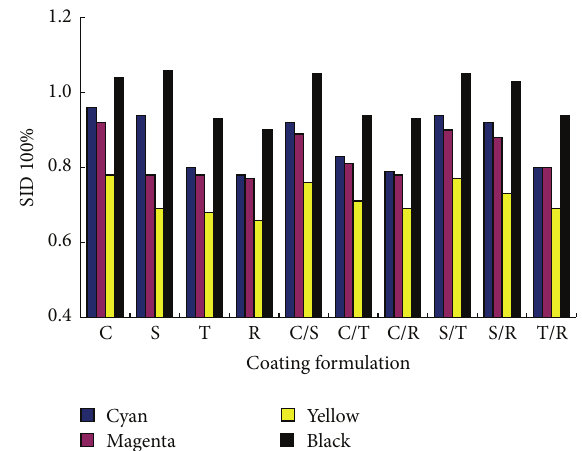
Figure 6: Effects of coating formulations on the cyan, magenta, yellow, and black (CMYK) solid ink densities of inkjet-printed papers, C: CaCO 3 ; S: SiO 2 ; T: talc; R: sericite, with mixing ratios of